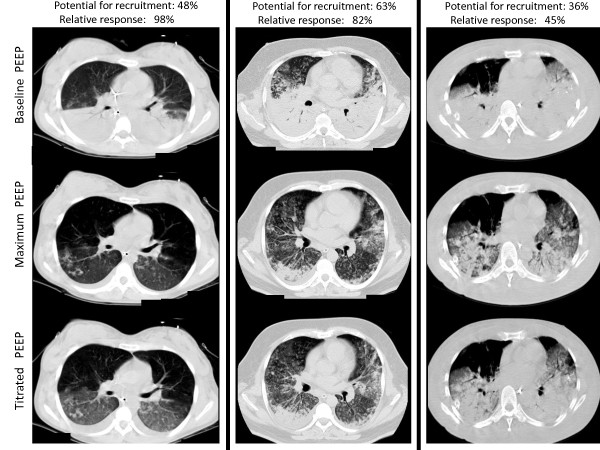
Illustrative cases of MRS. One with best relative-response (98% - left column), one with typical median response (82% - mid column), and another with the worst response (45% - right column). As can be noticed, the measurement of the potentially recruitable lung does not match this relative response (with values of 48%, 63% and 36%, respectively), since this last parameter is also strongly coupled with the amount of non-aerated tissue at baseline PEEP (49%, 78% and 80%, respectively).